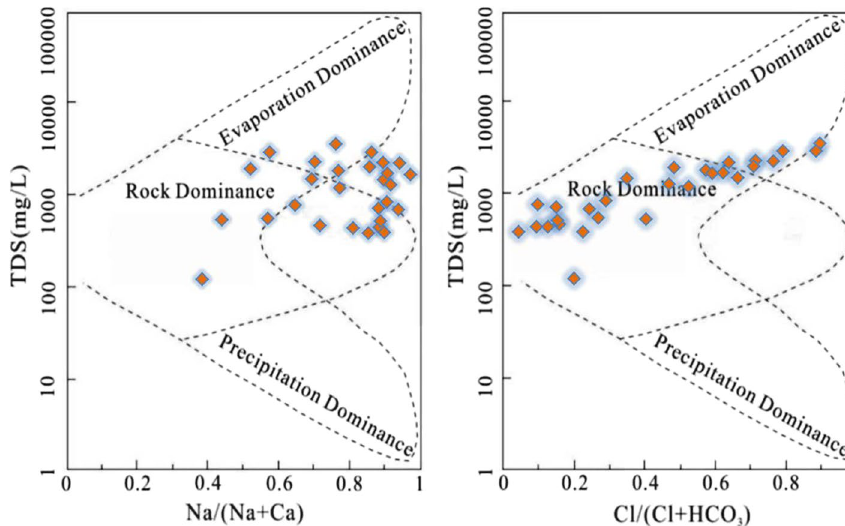
Fig. 4 Gibbs diagram repre- senting dominant factors of groundwater